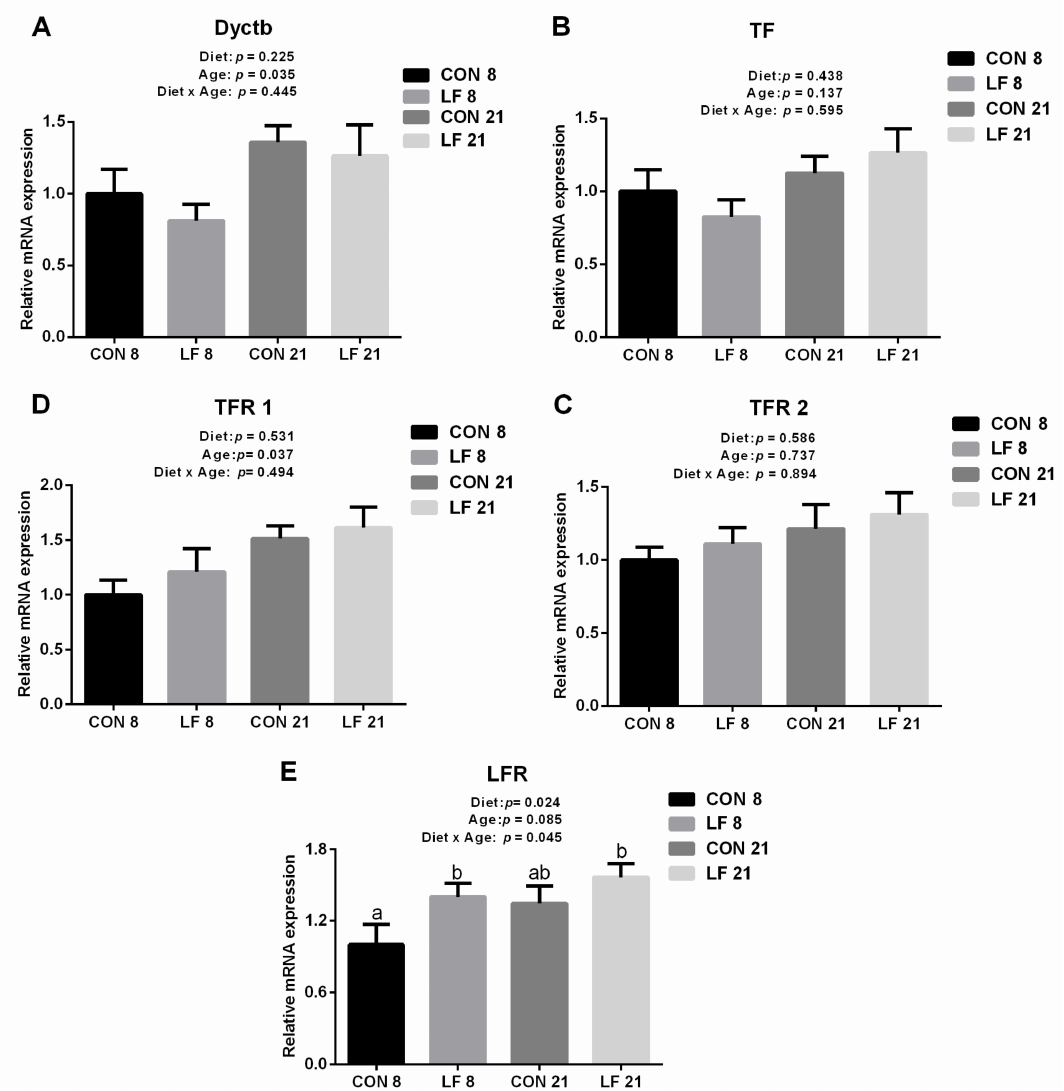
Figure 1. E ff ects of lactoferrin on gene expressions related to iron metabolism in the duodenum of suckling piglets. ( A ) duodenal cytochrome b (Dcytb) ( B ) transferrin (TF) ( C ) transferrin receptor 1 (TFR 1) ( D ) transferrin receptor 2 (TFR 2) ( E ) lactoferrin receptor (LFR). Values are means, standard errors represented by vertical bars, n = 6 per treatment. a-b Di ff erent letters mean significantly di ff erent for di ff erent groups at p < 0.05. CON 8, control group on day 8; LF 8, Lactoferrin group on day 8; CON 21, Control group on day 21; LF 21, Lactoferrin group on day